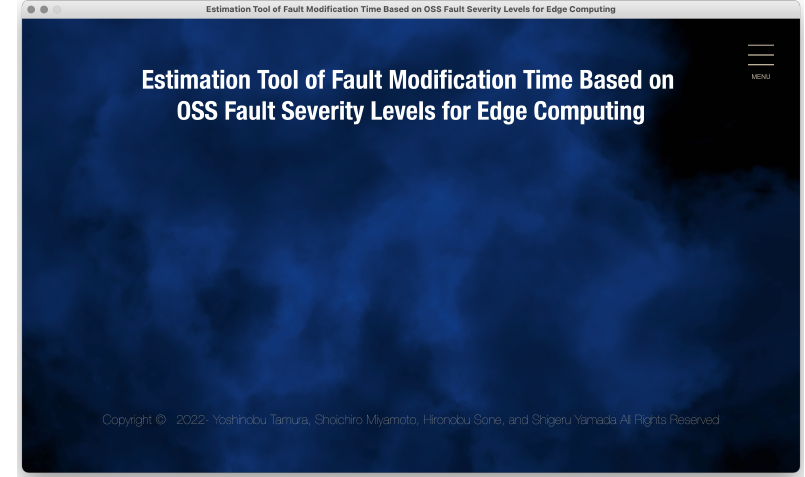
Figure 6. The main screen of our tool.